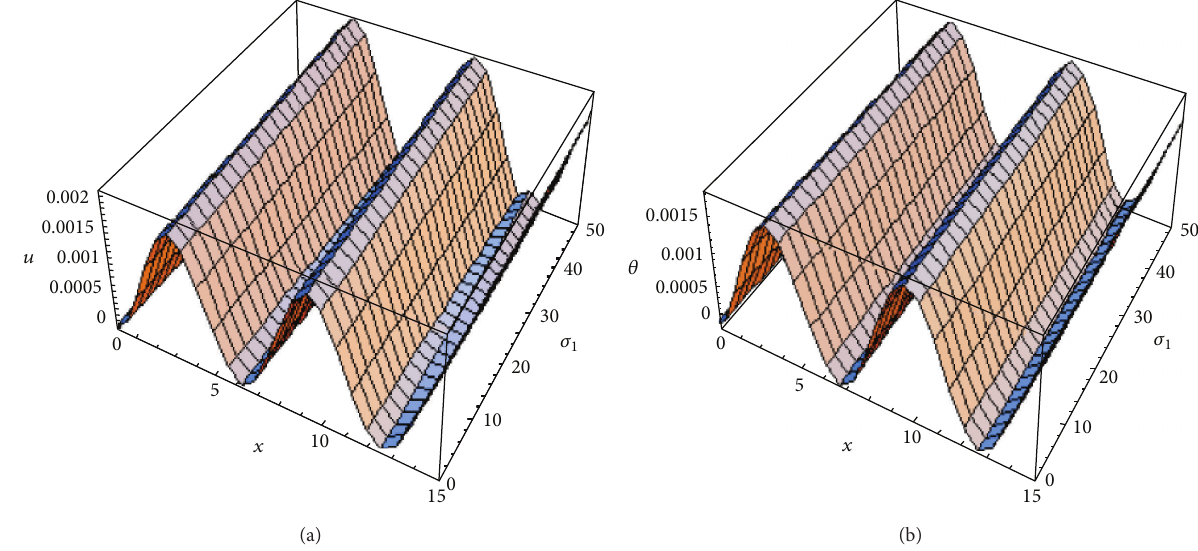
Figure 10: Variations of the displacement 𝑢 and the temperature 𝜃 for various values of the 𝑥 -axis and magnetic field 𝜎 1 when Ω = 𝜎 2 = 0 , = 0.2 , 𝜏 = 0.1 , 𝛿 = 0 , and 𝜔 = 0.02 . 𝑡 = 0.1 , 𝜏 2 1